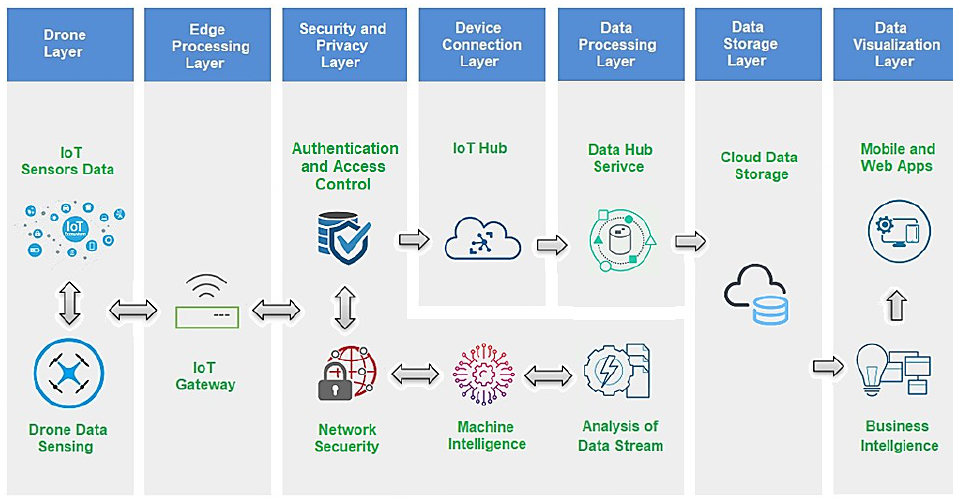
Figure 2. Proposed architecture for smart drone